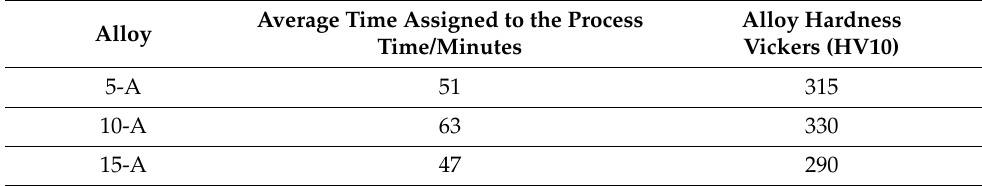
For 3 assemblies of prosthetic framework made by 3 methods (RD, DC and CoM) were analyzed, five images that represent segments of sections (Image 1, Image 2, Image 3, Image 4 and Image 5) with 5 measurements (d1, d2, d3, d4 and d5) in ( µ m) (Figure 15) (Tables 5–8) were